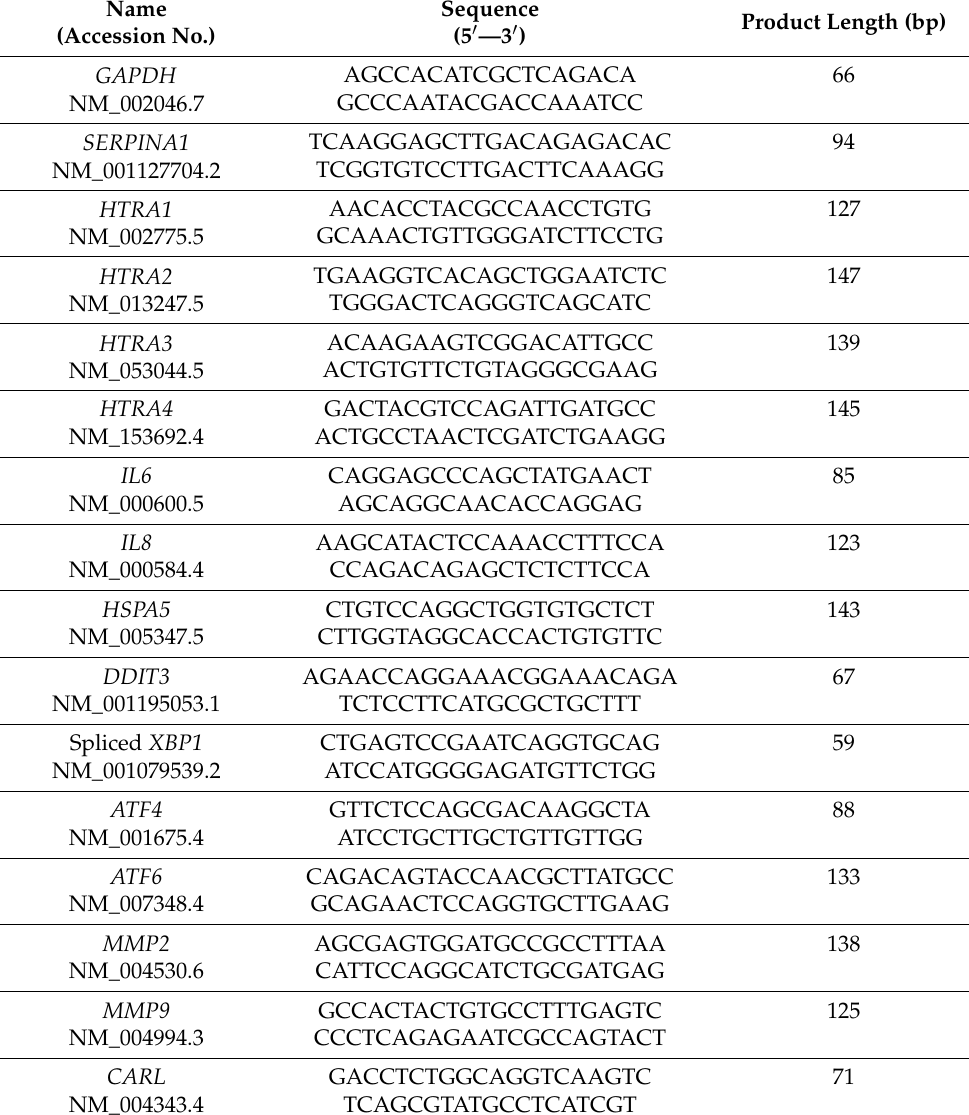
Table 1. Primers for real-time qPCR